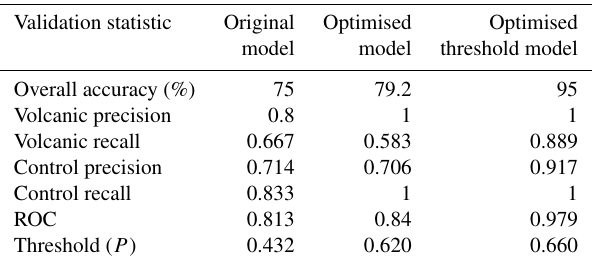
Table 6. Validation statistics generated through the assessment of the test data with three